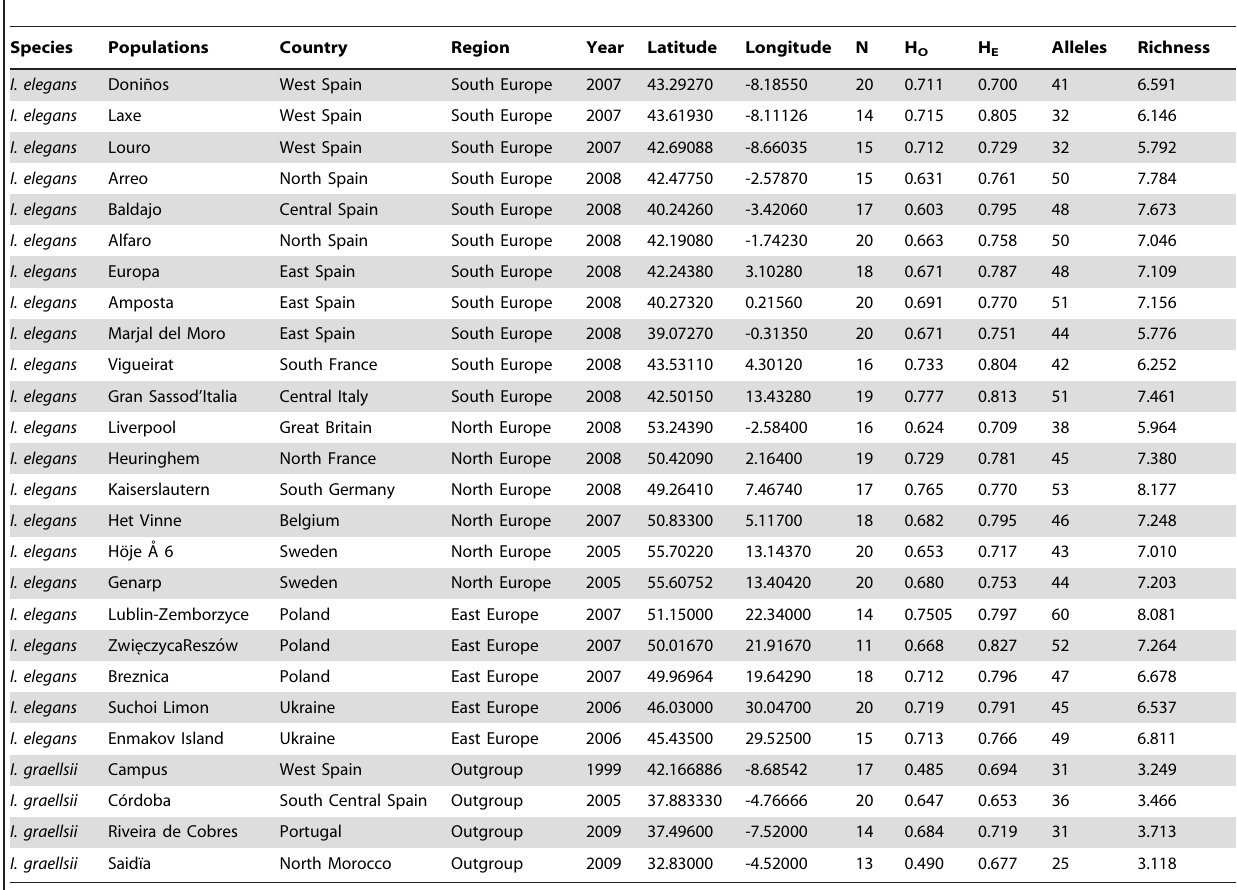
Table 1. Population